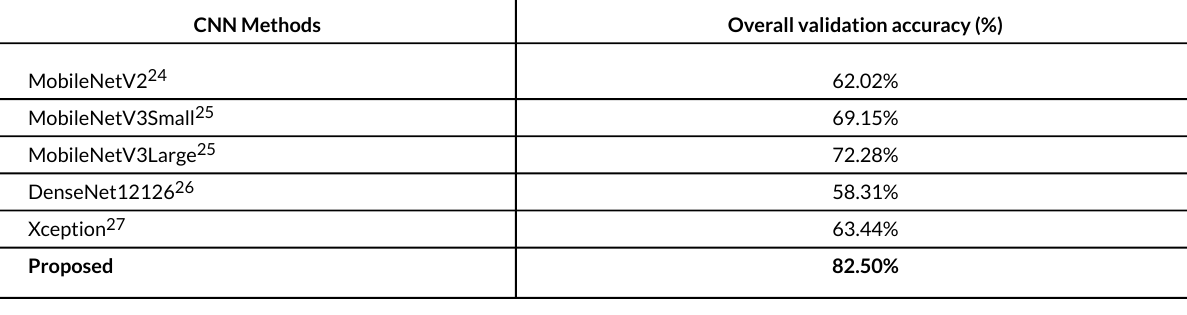
Table 1. Comparison of proposed feed-forward network with other models.